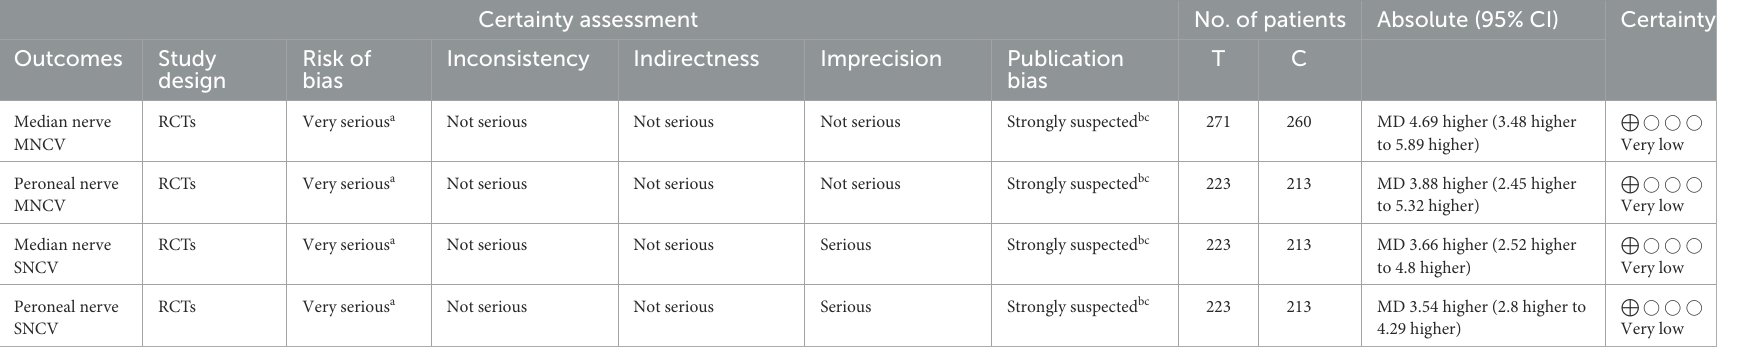
TABLE 5 GRADE quality grading